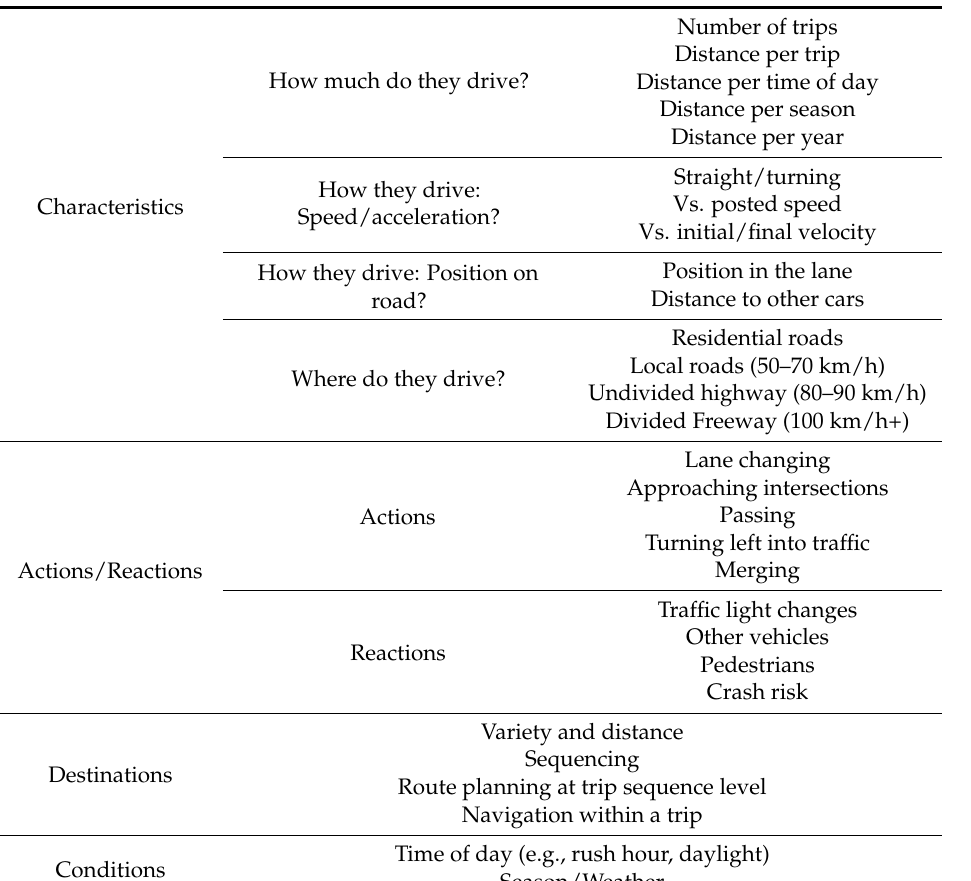
Table 2. Driving